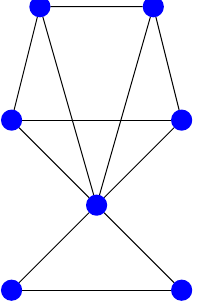
Figure 5. The third cospectral graph with seven